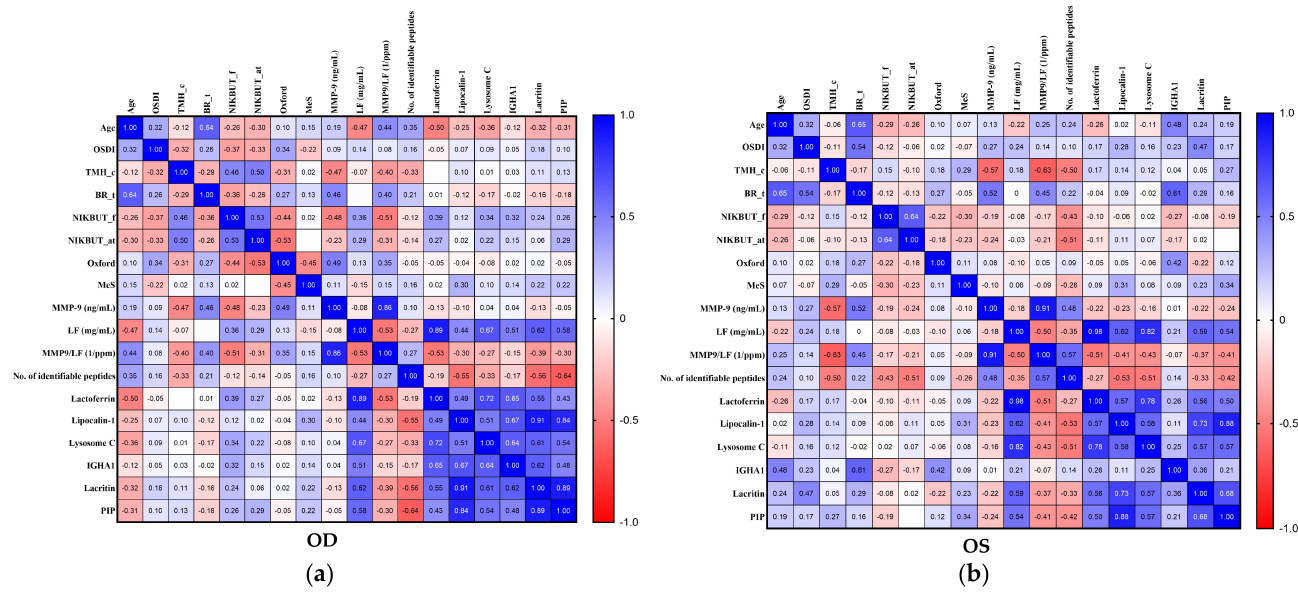
1 Figure 6. Association between representative ocular surface homeostatic markers and tear biomarkers in the ipsilateral eye.